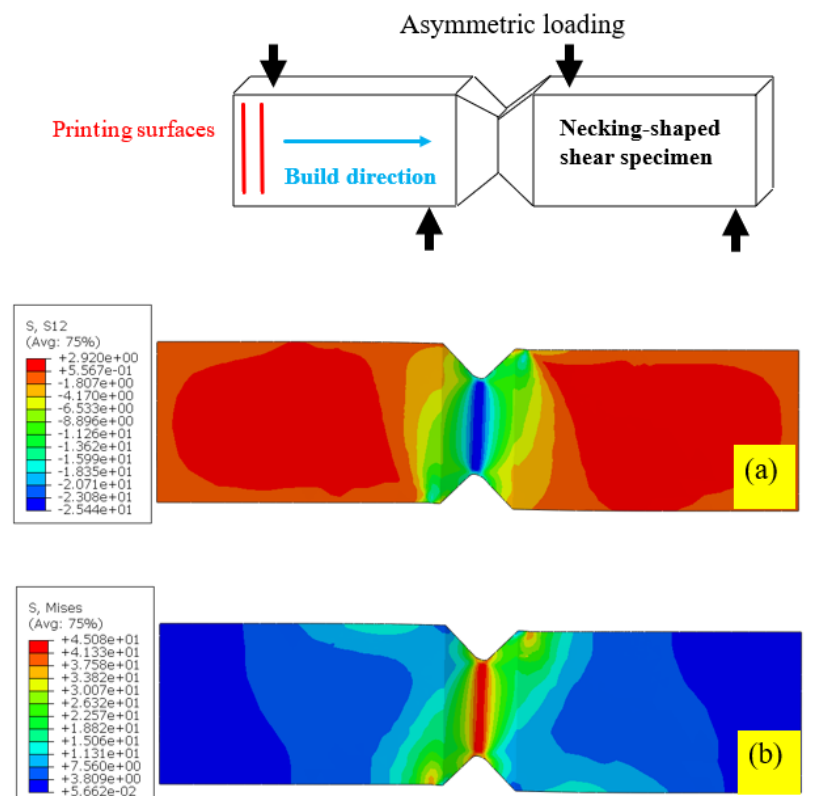
Figure 2. Contour plots of ( a ) shear and ( b ) von Mises stresses from the FEA of a PA necking-shaped specimen (applied displacement of 1 mm). Table 1. Interlayer shear strengths of the same PA 12 polymer made with SLS and